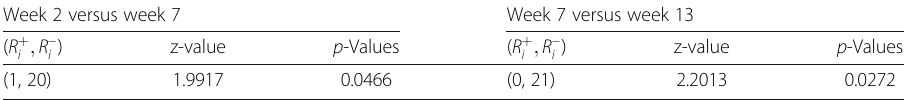
Table 5 Results from the Wilcoxon signed ranks test with a significance level of p = 0.05 Week 2 versus week